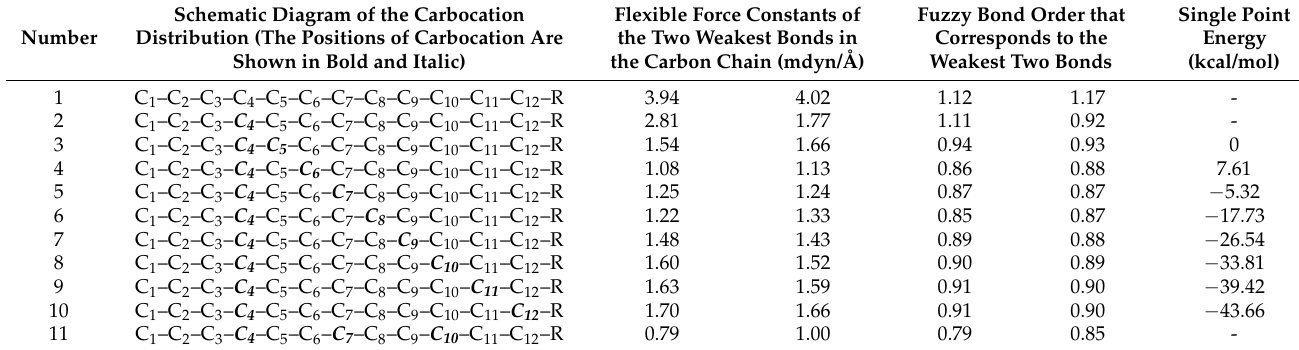
Table 2. The strength of the two weakest bonds in the carbon chain in the presence of carbocations (letters in italic) and the energy of the molecules containing two carbocations. Schematic Diagram of the Carbocation Number Distribution (The Positions of Carbocation Are Shown in Bold and Italic)